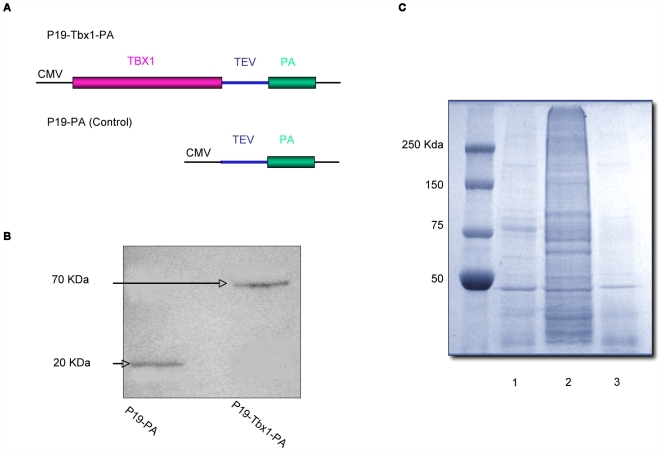
Identification of Tbx1 interactors using affinity purification.Mouse P19-Cl6 embryonic carcinoma cells were stably transfected with plasmid expressing TEV-protein-A alone or C-terminally fused to Tbx1 and induced to differentiate with 1% DMSO. a) Constructs used to generate stably transfected P19CL6 cell clones. b) Western blot analysis of P19-Tbx1-PA and P19-PA (control) cell extracts. Proteins were separated by gel electrophoresis on 10% SDS-PAGE gel and immunoblotted with human IgG F(c), which recognize protein A. c) Colloidal coomassie-stained 10% SDS-PAGE gel containing nuclear extracts from P19-Tbx1-PA (lane 1) and P19-PA (lane 3) cells affinity purified by binding to IgG-Sepharose and then enzymatically eluted by cleavage with TEV protease. Compared with non-purified nuclear extract from Tbx1-TEV-PA cells (lane 2).